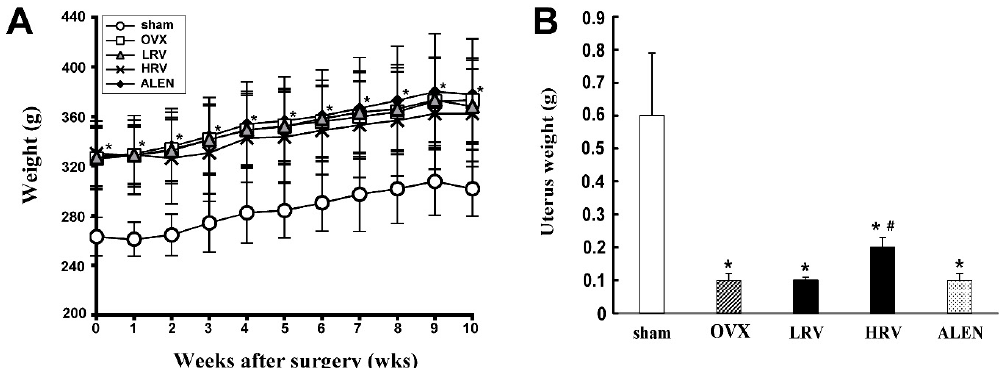
Figure 1. Effects of Rubus coreanus (RC) vinegar on body weight ( A ) and uterus weight ( B ) in ovariectomized rats. Data are expressed as the mean ± SD ( n = 8). sham, sham-operated control; OVX, ovariectomized rat without treatment; LRV, ovariectomized rat treated with low-dose RC vinegar; HRV, ovariectomized rat treated with high-dose RC vinegar; ALEN, ovariectomized rat treated with alendronate. * p < 0.05 compared to the sham, # p < 0.05 compared to the OVX group.